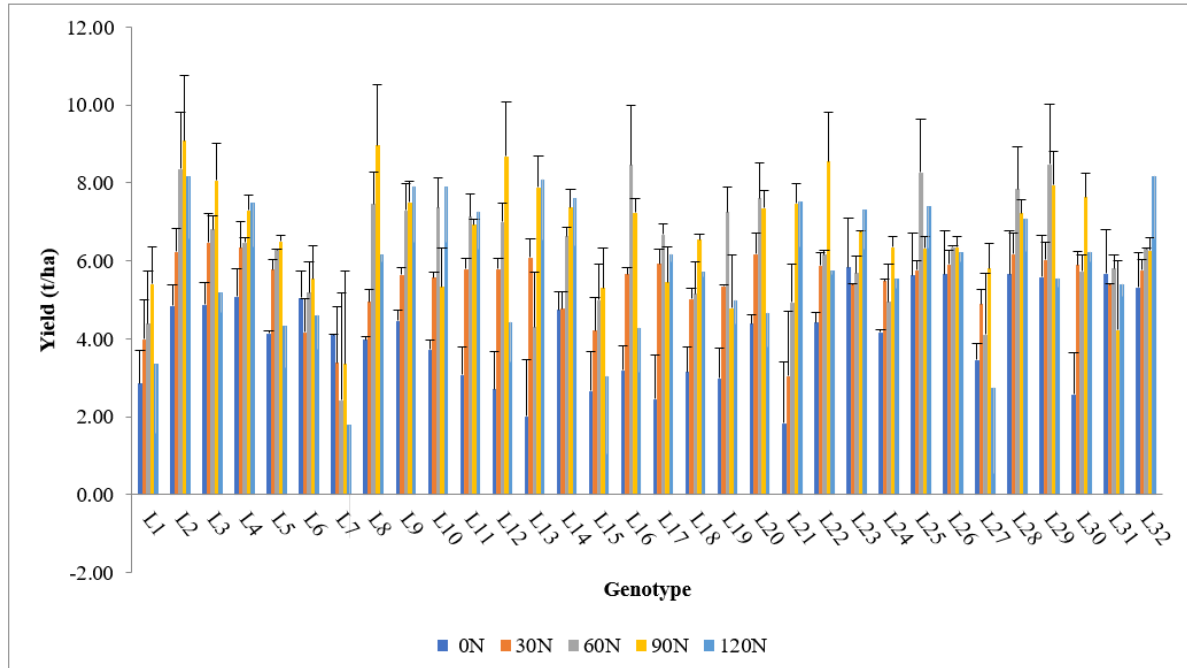
Figure 2. Yield performance of QPM inbred lines at different levels of nitrogen application.